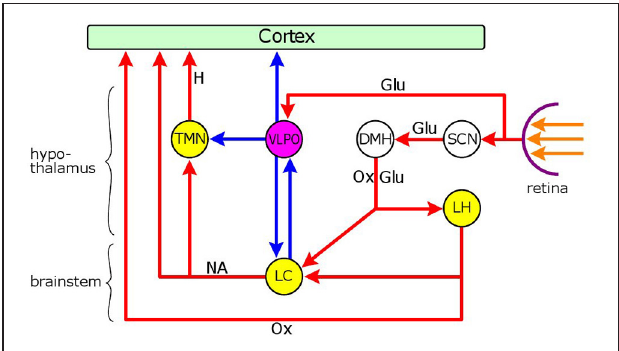
FIGURE 3 | Neuronal network mediating the dual effect of light on arousal. Nuclei: yellow: wakefulness-promoting, purple: sleep-promoting. Connections: red: excitatory, blue: inhibitory. Hypothalamic nuclei: SCN, suprachiasmatic nucleus; DMH, dorso-medial hypothalamus; LH, lateral hypothalamic area; VLPO, ventrolateral preoptic nucleus; TMN, tuberomamillary nucleus; brainstem nucleus: LC, locus coeruleus. Neurotransmiters: Glu, glutamate; Ox, orexin; NA, noradenaline; H, histamine. Light reaching the retina has a sleep-promoting effect via the excitatory output of melanopsin-containing intrinsically photosensitive retinal ganglion cells (ipRGCs) to the VLPO, the major sleep-promoting